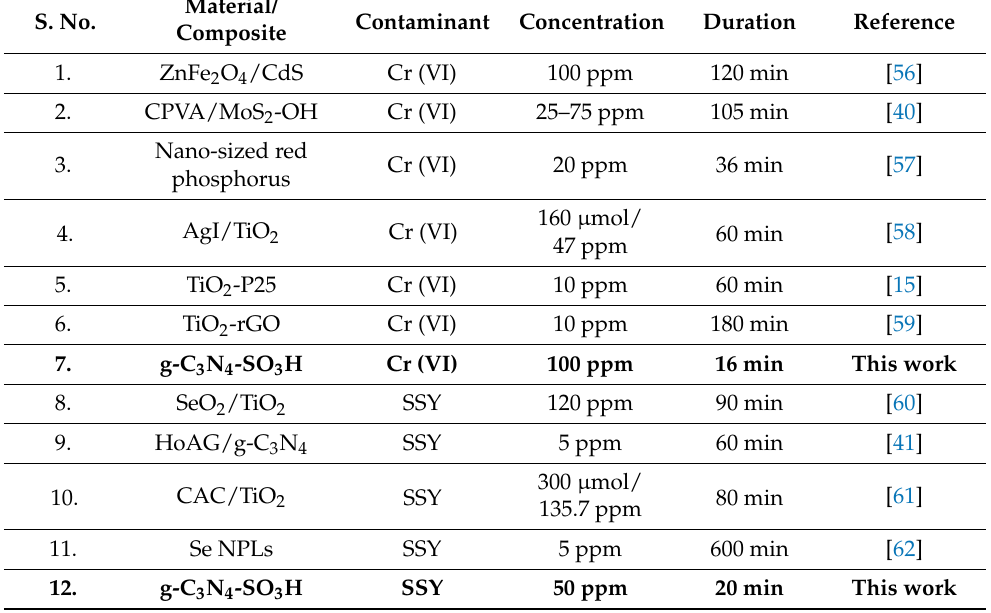
Table 1. Comparative analysis of the photocatalytic ability of various catalytic materials across different contaminant concentration